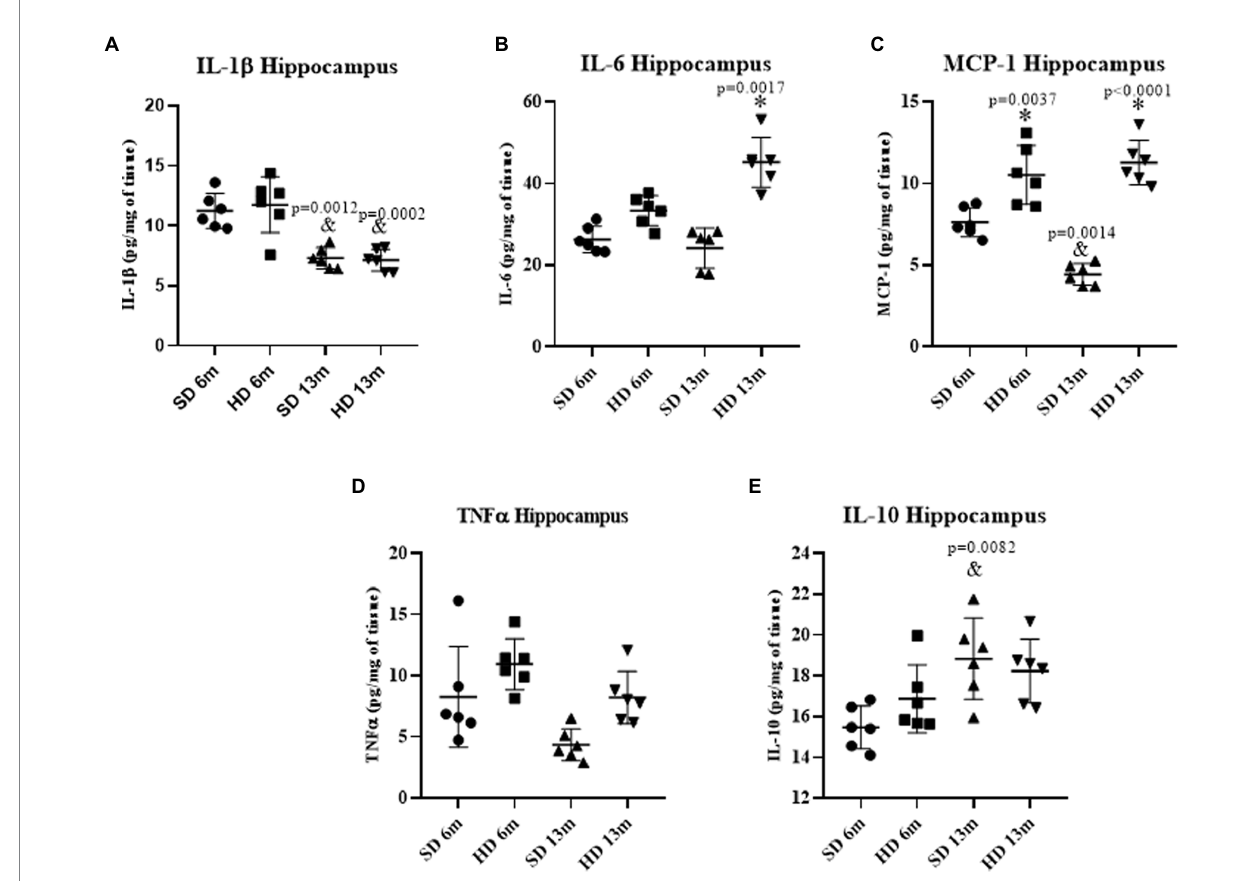
FIGURE 4 Hippocampus inflammatory profile. The levels of IL1 β (A) , IL6 (B) , MCP-1 (C) , TNF α (D) , and IL10 (E) were analyzed by ELISA ( n = 6 SD and n = 6 HD). The data represent the mean ± SD and were analyzed by two-way ANOVA, followed by a Tukey’s post hoc test. The significant differences between groups compared to the SD are marked with ∗ , and differences at different ages are marked with & p < 0.05.